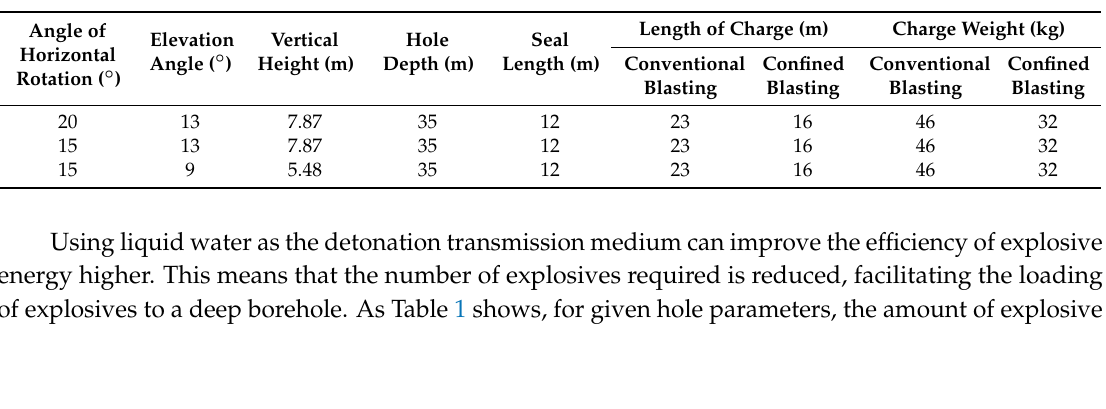
Table 1. Blast parameters for the two blasting